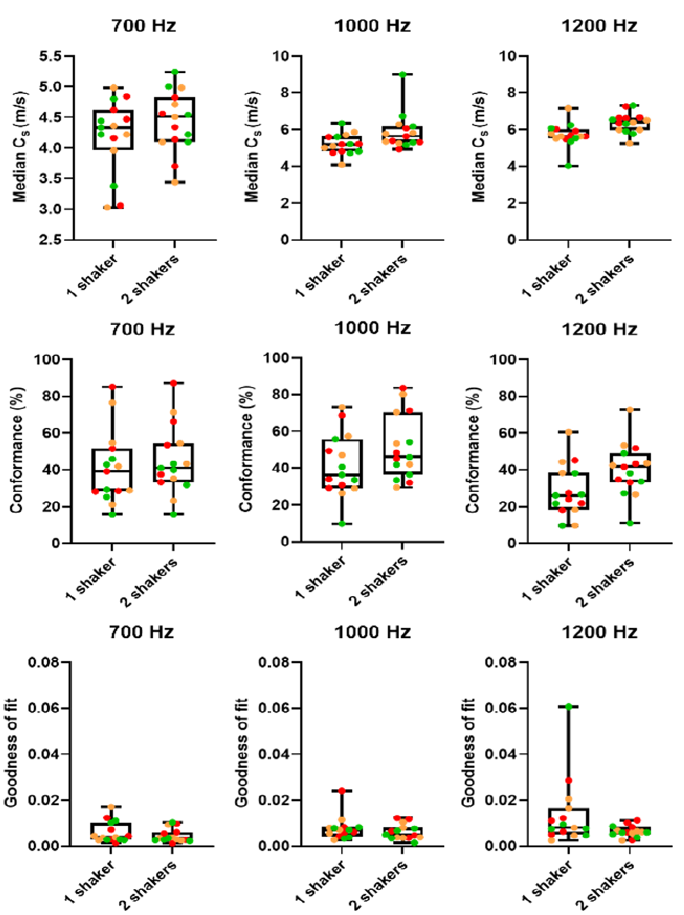
Figure A2. Box plots and whisker plots of c s , C and GoF in MDA-MB-231 tumours as measured on three consecutive days. We compared median c s , mean C and mean GoF for one and two vibrational sources (shakers) from all tumours ( n = 5). There was no significant difference in C and GoF for two vibrational sources compared to one. Median c s was greater for two shakers but not significantly so.